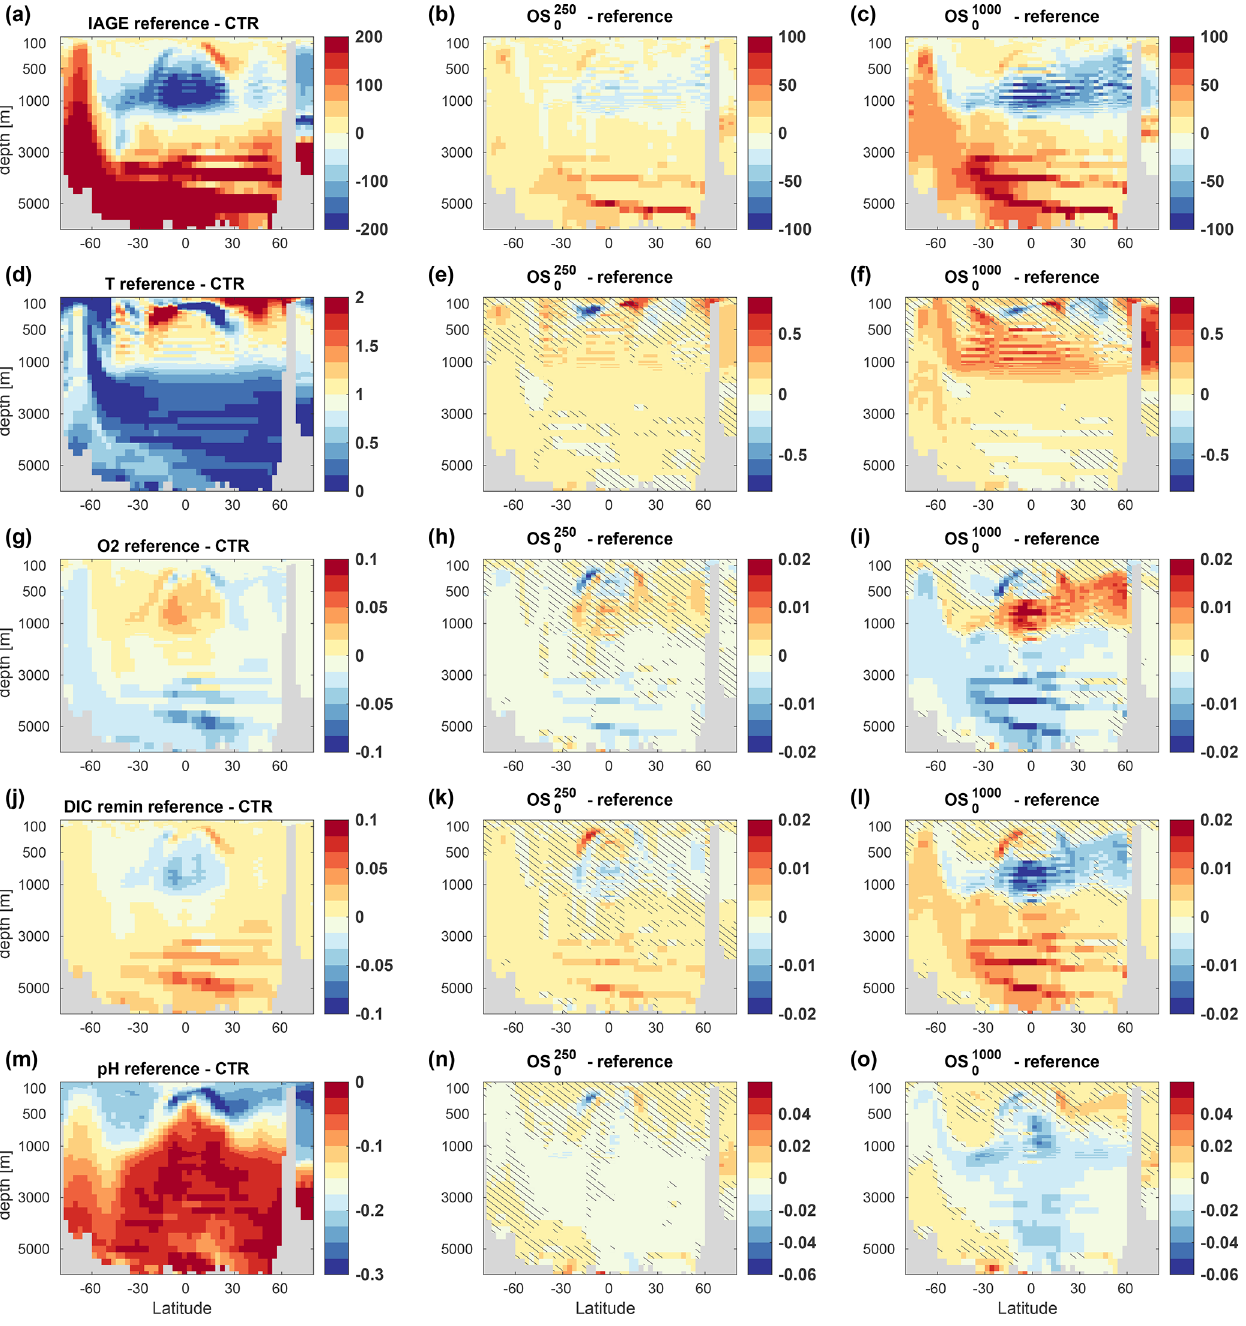
Figure A4. As Fig. 10 but showing REV 95 for the short overshoot duration for a zonal mean section through the Pacific.